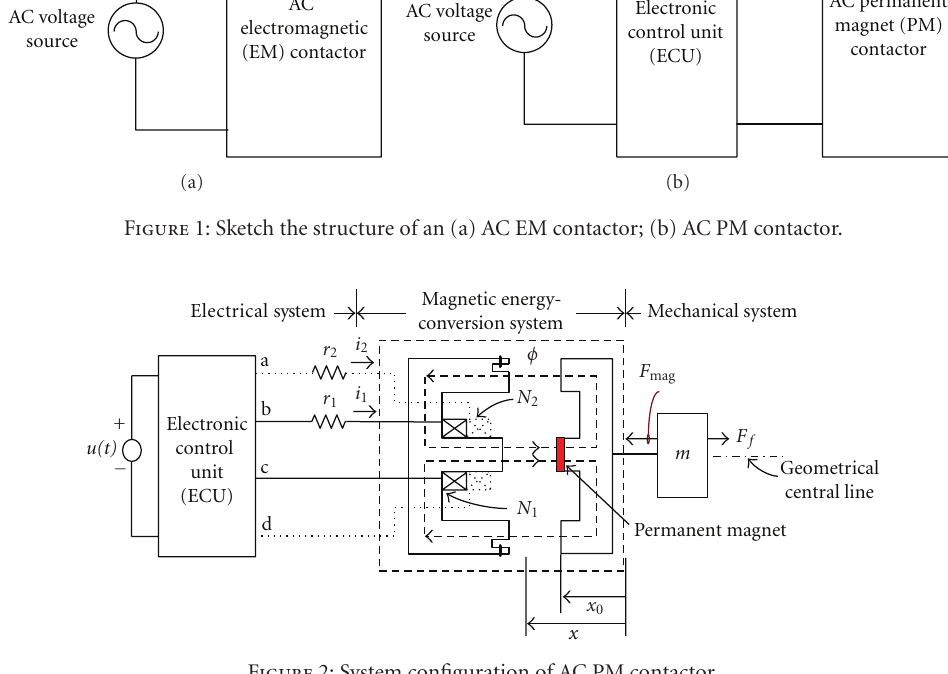
Figure 2: System configuration of AC PM